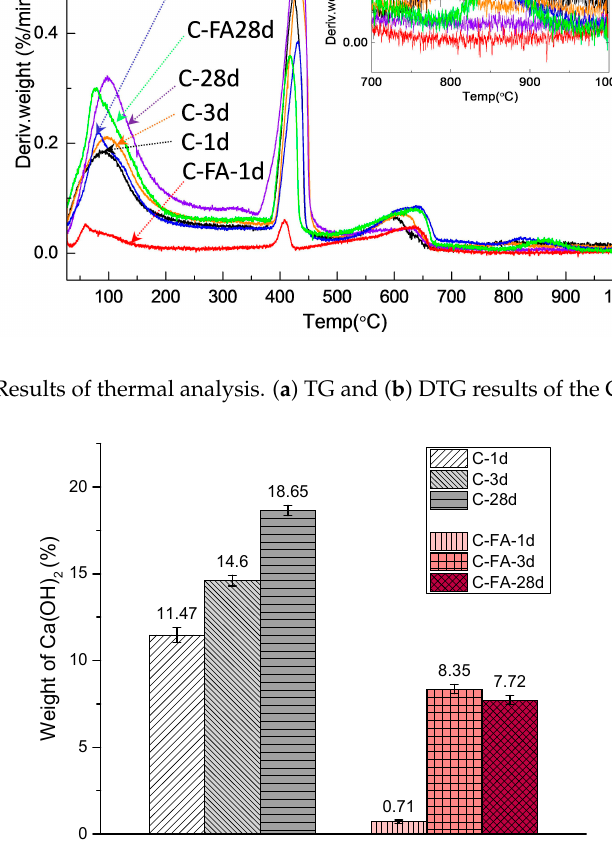
Figure 3. Amount of produced Ca(OH) 2 as a percentage of total weight in C and C-FA. The Ca(OH) 2 content was normalized against the C 3 S content of the pastes.